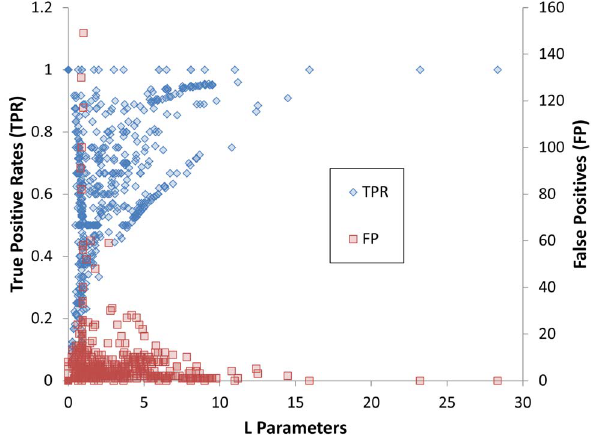
Figure 4. The relationships between L parameters and 1) the True Positive Rate (blue dots); and 2) the number of total False Positives (red dots) for 555 bioassays.